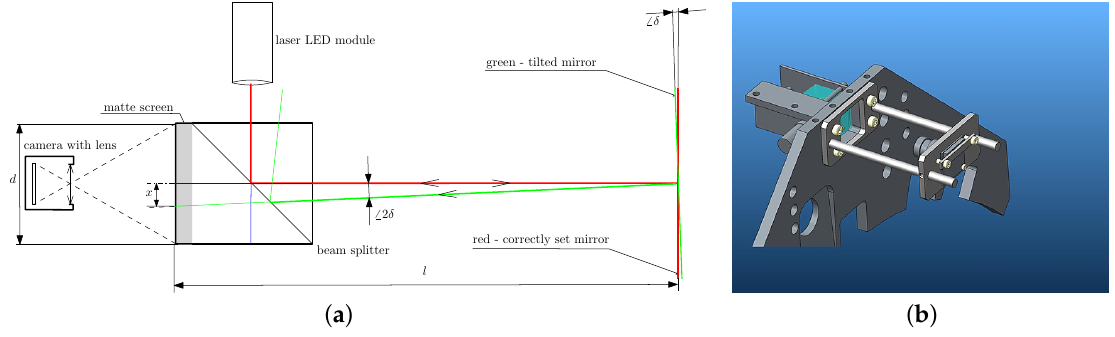
Figure 13. ( a ) Auto-collimator principle; ( b ) solid drawing of the auto-collimator